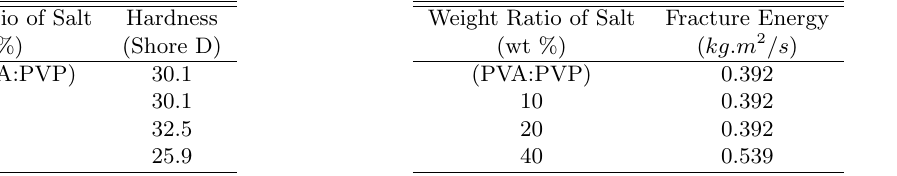
Table 2: Hardness values of pure and PVA:PVP poly- mer blend films reinforced with different weight ratios of CdCl 2 · H 2 O salt.